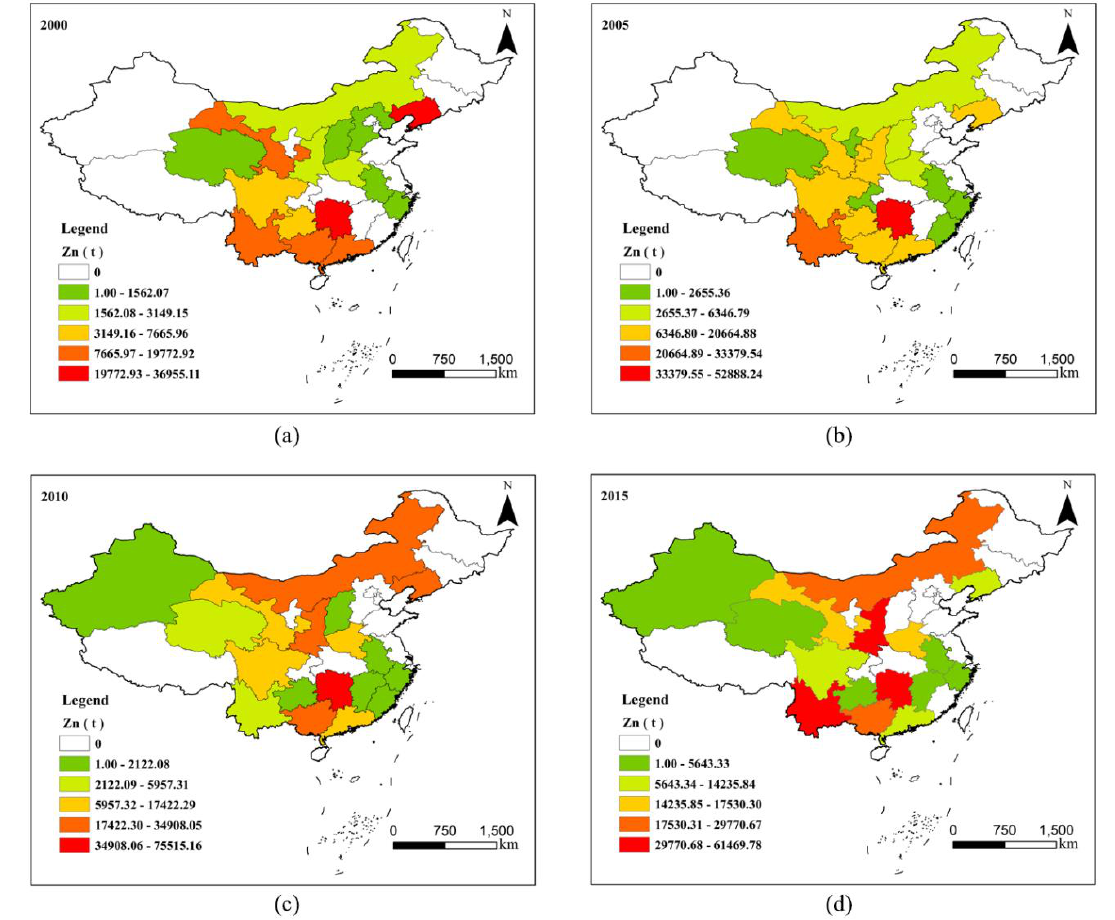
Figure 3. Spatial distribution characteristics of Zn environmental release in China. ( a ) spatial distribution of Zn in 2000; ( b ) spatial distribution of Zn in 2005; ( c ) spatial distribution of Zn in 2010; ( d ) spatial distribution of Zn in 2015.